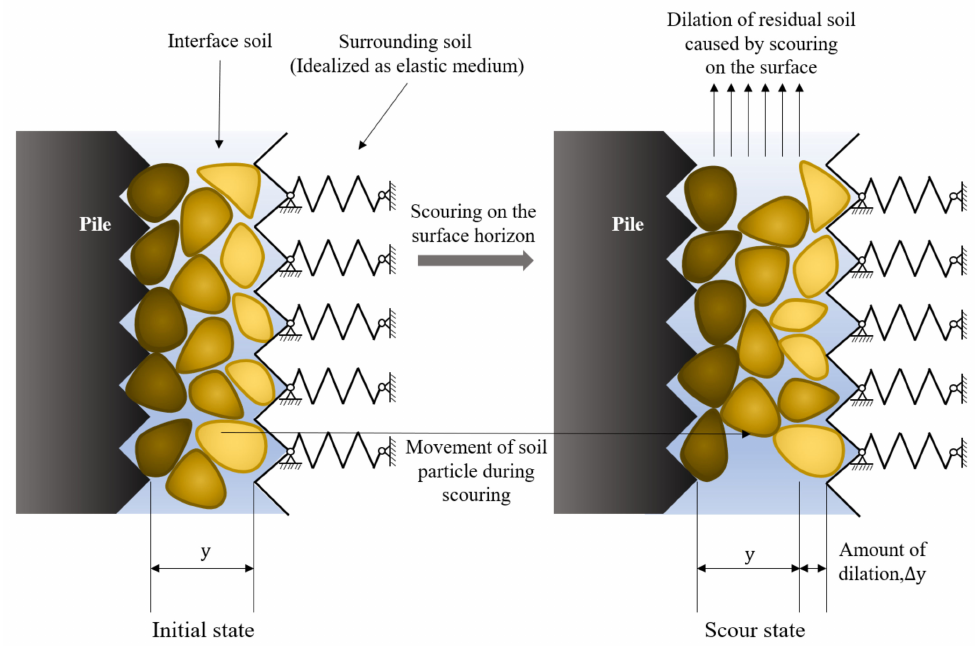
Figure 9. Dilatancy of shallow horizon of the remaining interface soil in local scour condition. To visualize the stress distribution of the interface and the surrounding soil under extrusion, the effective normal stress contour from the axial compression side in no scour and local scour conditions are extracted in this study. The displacement inflicted on the pile head is the limit in the standard of 0.2 D (1.2 m) and the stress contour of 525 kPa at the depth of the strengthening soil interface of local scour intensity is highlighted in Figure